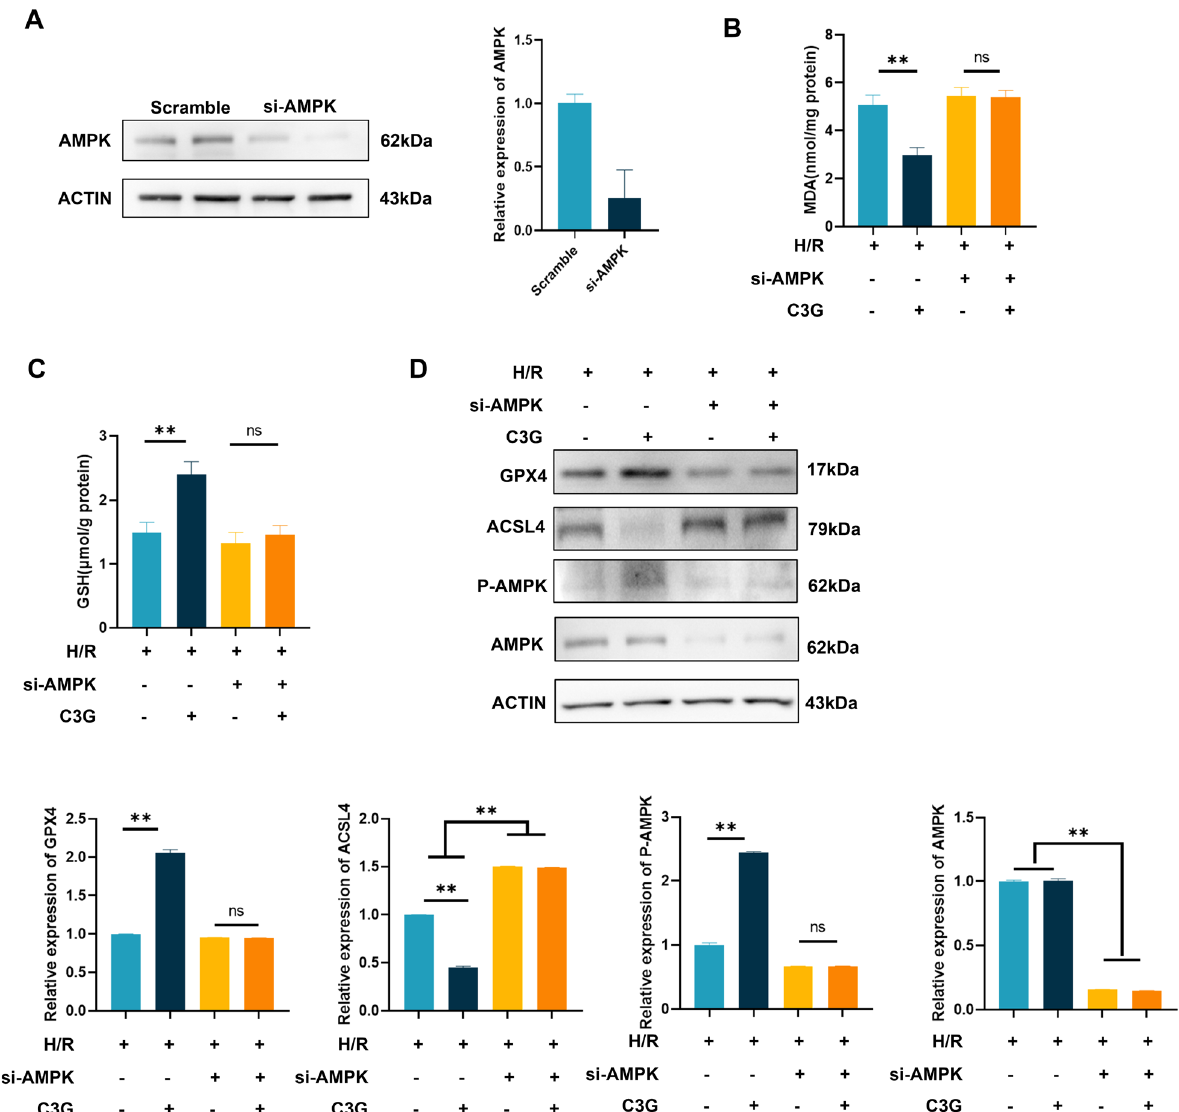
Fig. 6 The knockdown of AMPK abrogated the protective effect of C3G against ferroptosis. A The efficiency of knockdown of AMPK via si‑AMPK was analyzed by Western blot. (n 3); B , C The content of MDA and GSH were determined in HK‑2 cells with or without C3G after knockdown of = si‑AMPK under H/R condition. (n 6); D Western blot results of AMPK, P‑AMPK, GPX4 and ACSL4 in HK‑2 cells with or without C3G after knockdown = of si‑AMPK under H/R condition (n 3). *p < 0.05, **p < 0.001. C3G cyanidin‑3‑glucoside, HK-2 human proximal tubule epithelial cells, AMPK = AMP‑activated protein kinase, MDA malondialdehyde, GSH glutathione; GPX4 glutathione peroxidase 4, ACSL4 acyl‑CoA synthetase long chain family member 4, H/R